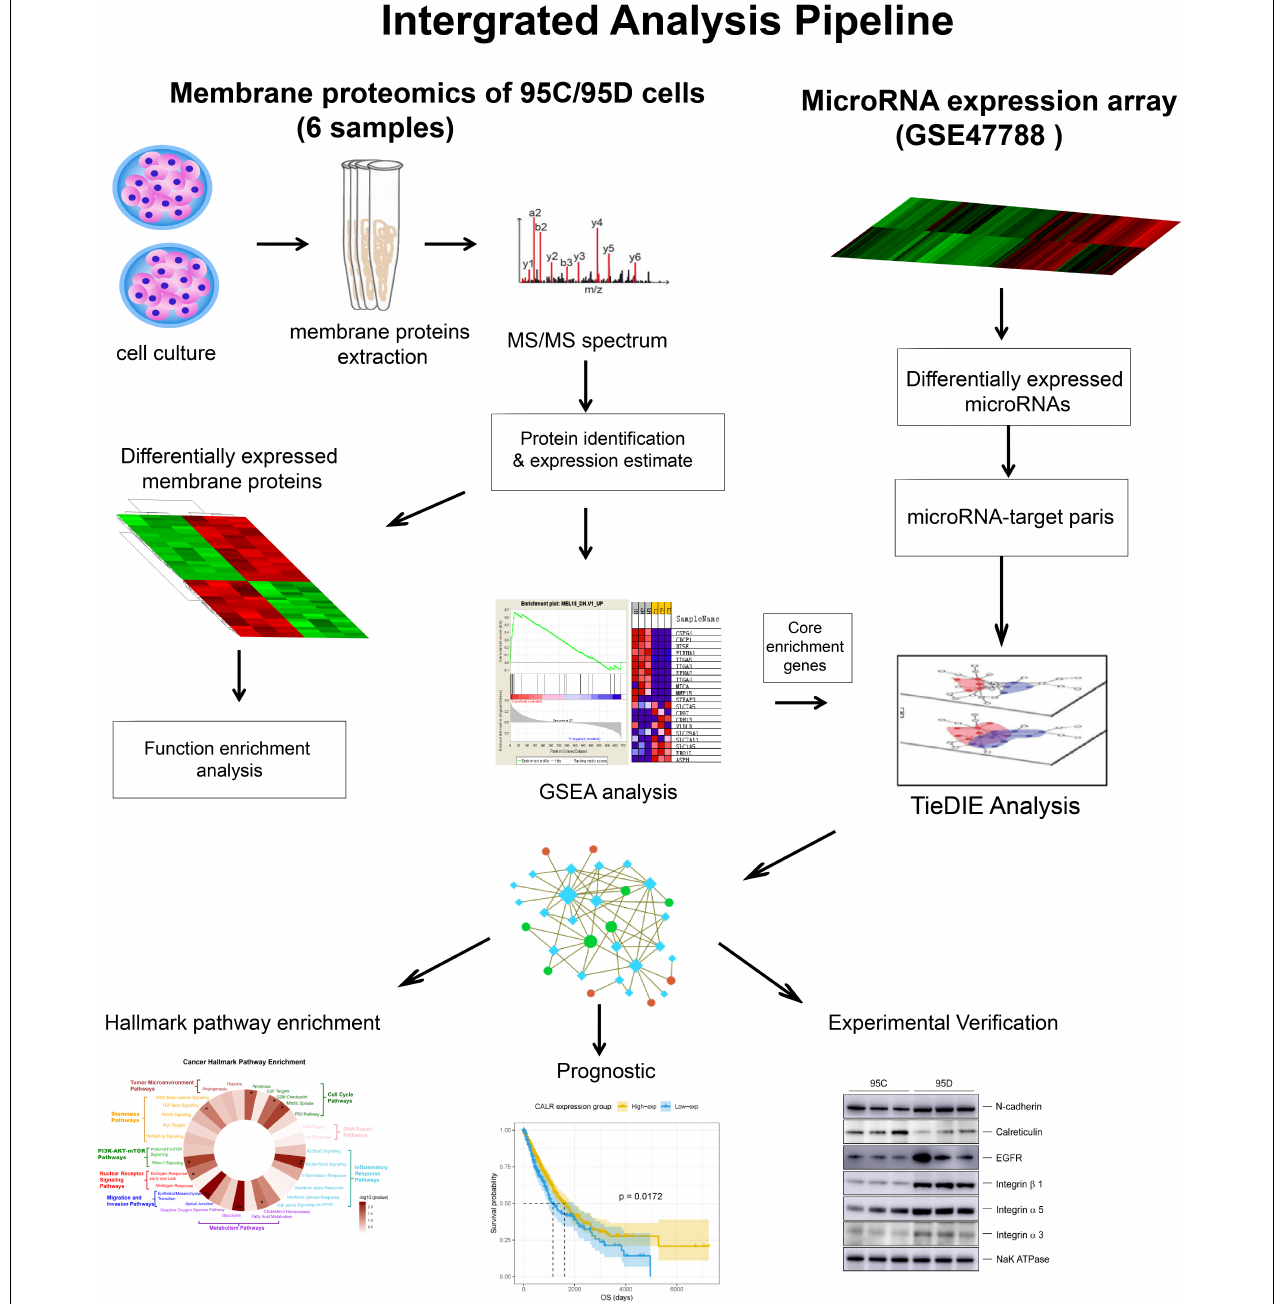
FIGURE 1 | Overall workflow of multi-omics integrative analysis.